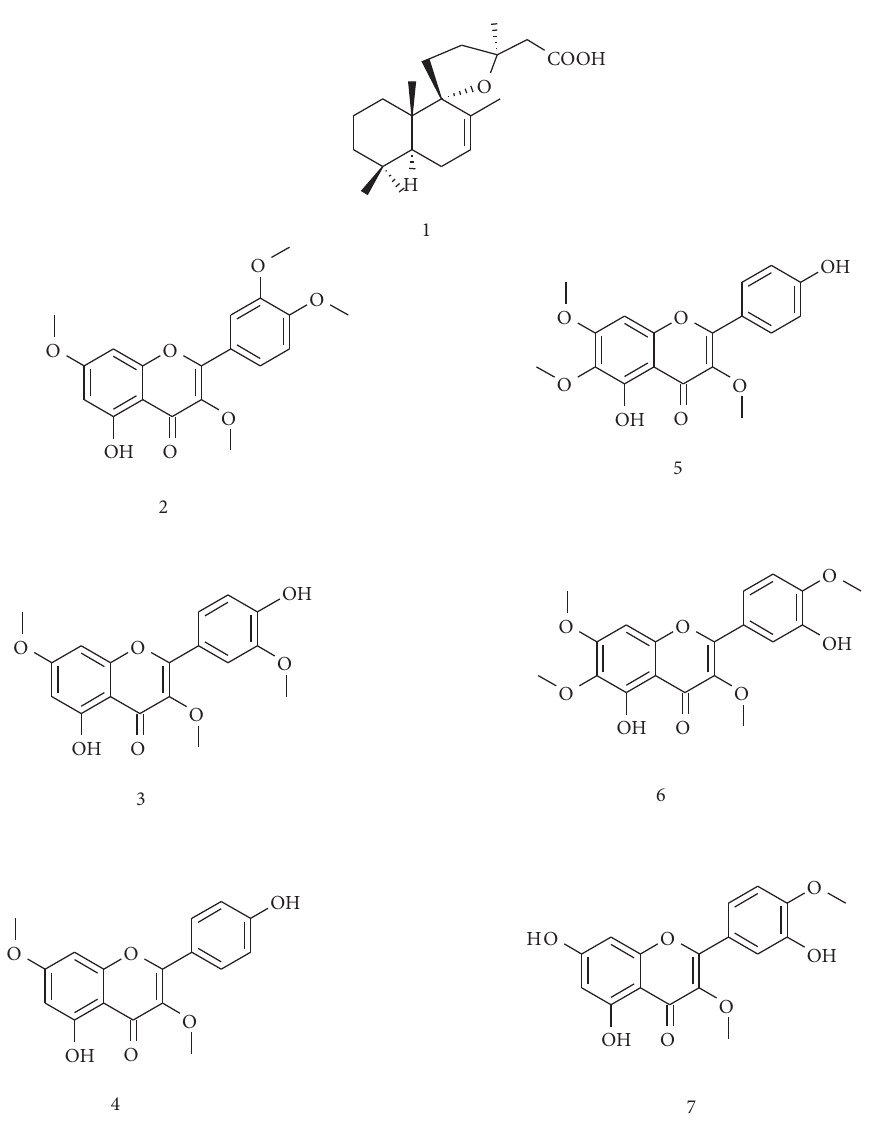
Figure 1: Chemical structures of the isolated